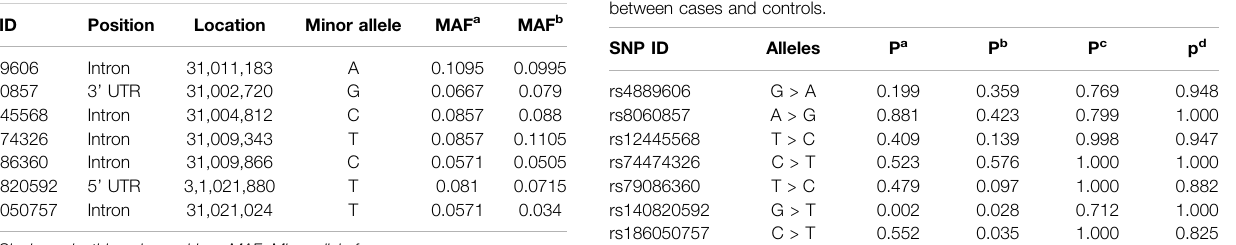
TABLE 2 | Basic information for seven STX1B